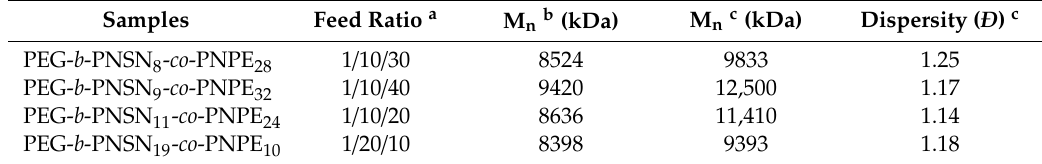
Figure 1. 1 H NMR spectra of ( a ) NSN–NCA in CDCl 3 , ( b ) NPE–NCA and ( c ) PEG- b -PNSN- co -PNPE in DMSO. * indicates solvents. Table 1. Characteristics of the triblock random copolymers synthesized. Table 1. Characteristics of the triblock random copolymers synthesized.